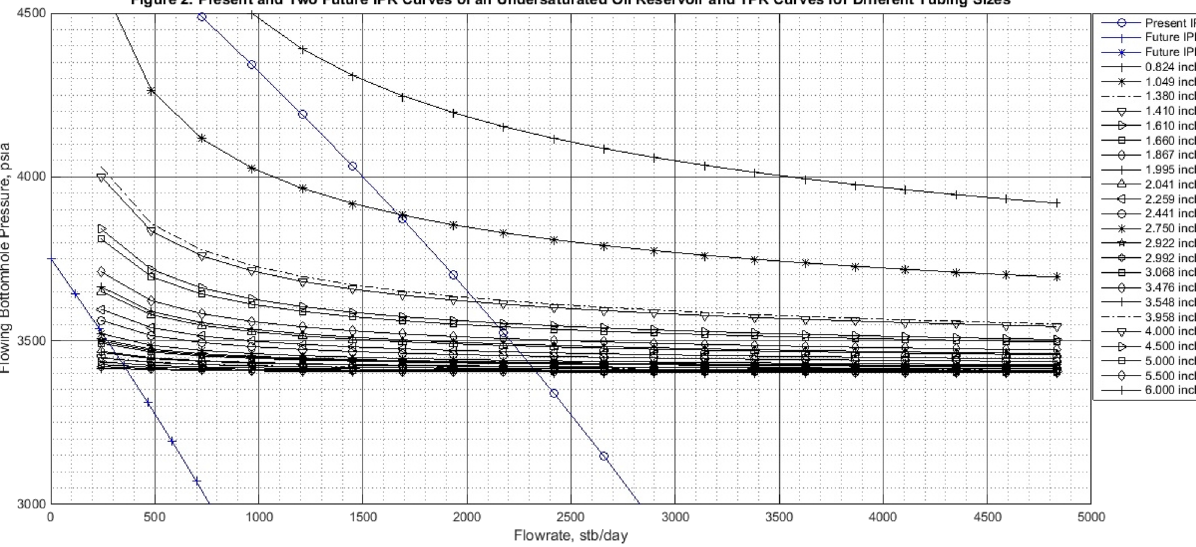
Fig. 6 Zoomed version of Fig. 5